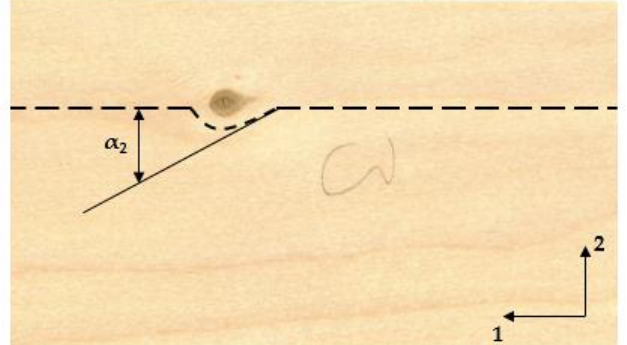
Figure 5. In-plane fiber deviation in the vicinity of a knot. Axis 1 represents the longitudinal direction of the veneer and axis 2 either the tangential or the radial direction respectively.